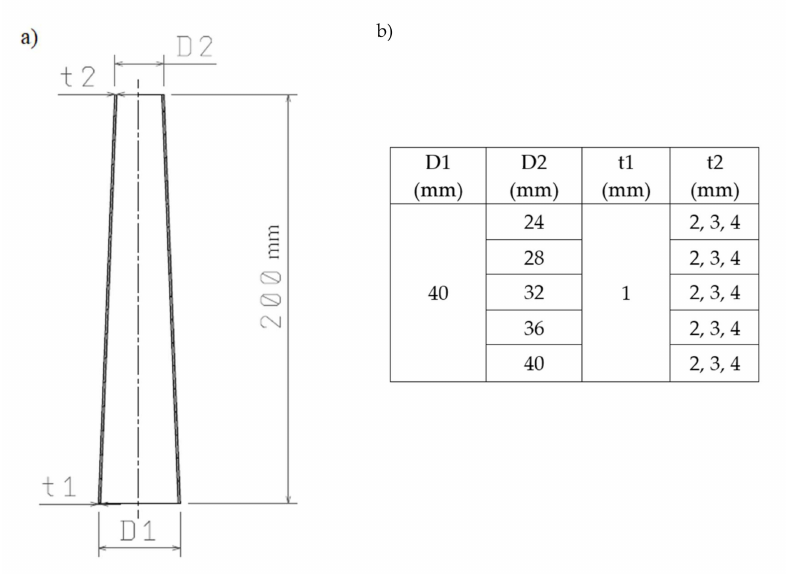
Figure 3. ( a ) The schematic drawing of the profile; ( b ) Variable cone parameters.